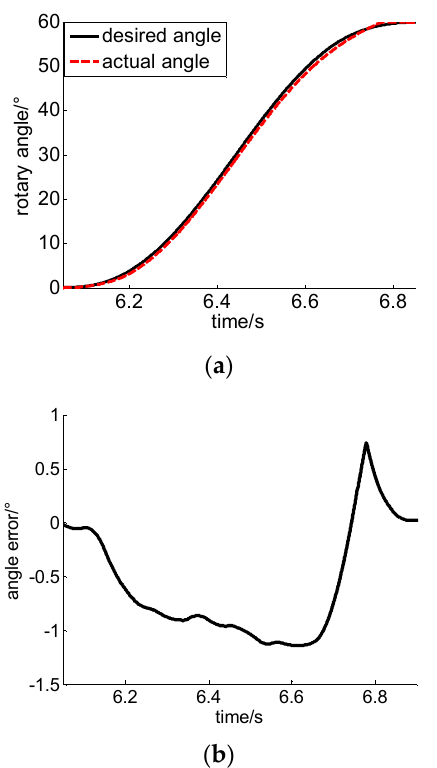
Figure 11. Test results of the rotary angle of the BLDC motor. ( a ) Rotary angle; ( b ) Error of rotary angle.